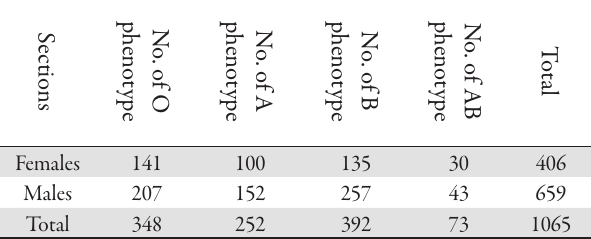
Tab. 5. Gender wise distribution of ABO blood group